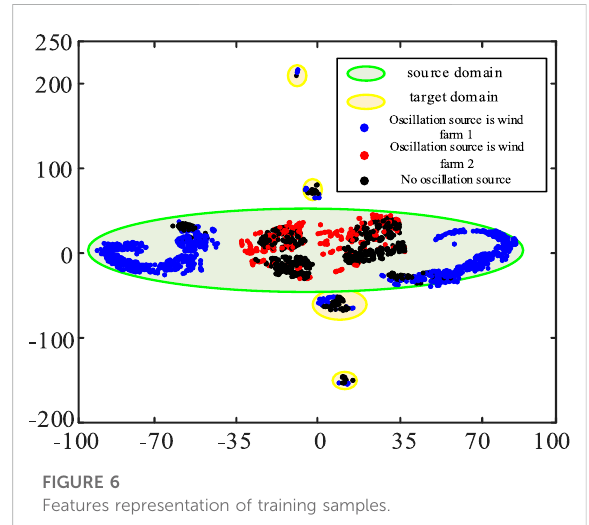
FIGURE 6 Features representation of training